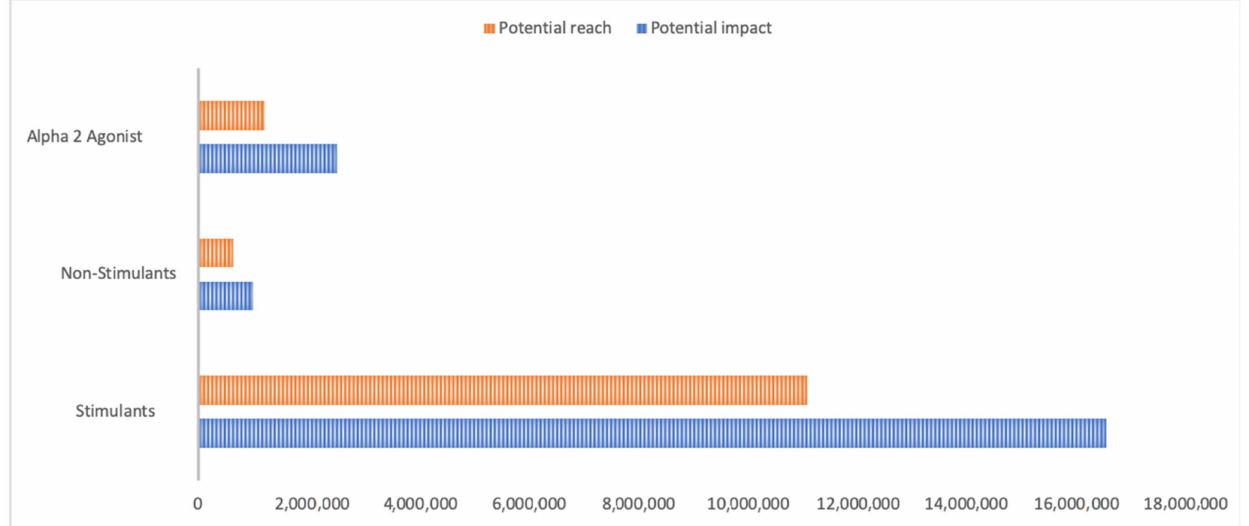
Figure 2. Potential reach and potential